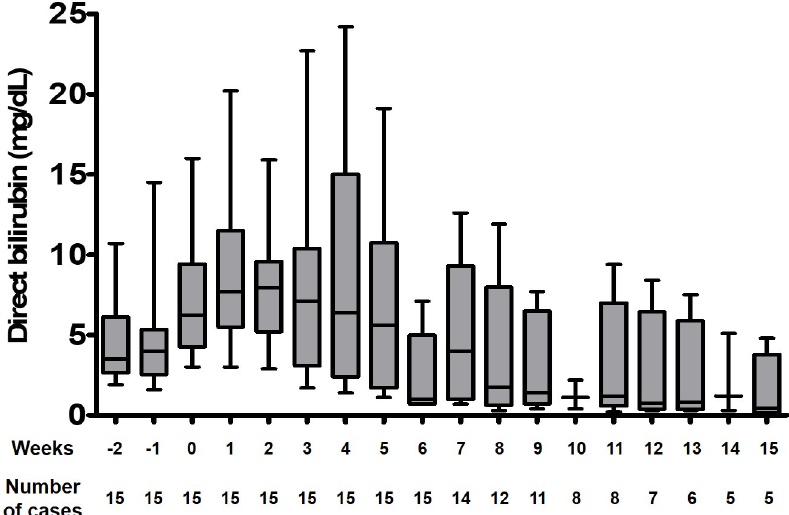
Figure 1. Direct bilirubin levels of 11 infants with intestinal failure-associated liver disease during fish oil monotherapy. Only data of those infants achieving IFALD reversal are represented in this graph. Week 0 indicates the time point of the initiation of fish oil monotherapy.